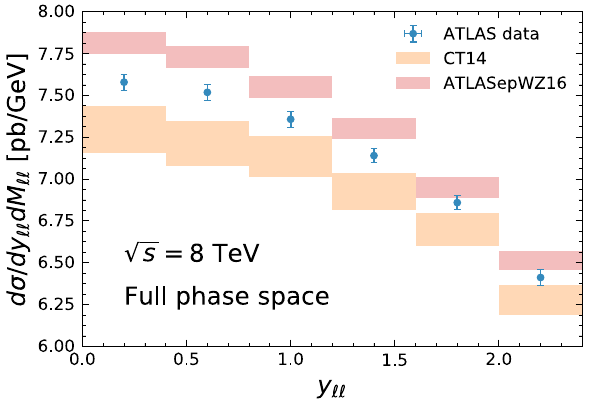
Fig. 8 Full phase space measurement of d σ/ d y (cid:4)(cid:4) compared to pre- dictions using various PDFs computed at NNLO using MCFM v9. Globalnormalizationuncertaintyof1 . 9%isnotshown. Errorbarsshow total data uncertainties. Bands indicate PDF uncertainties of the predic- tions. For ATLASepWZ16, the uncertainties are computed using the ATLASepWZ16-EIG set